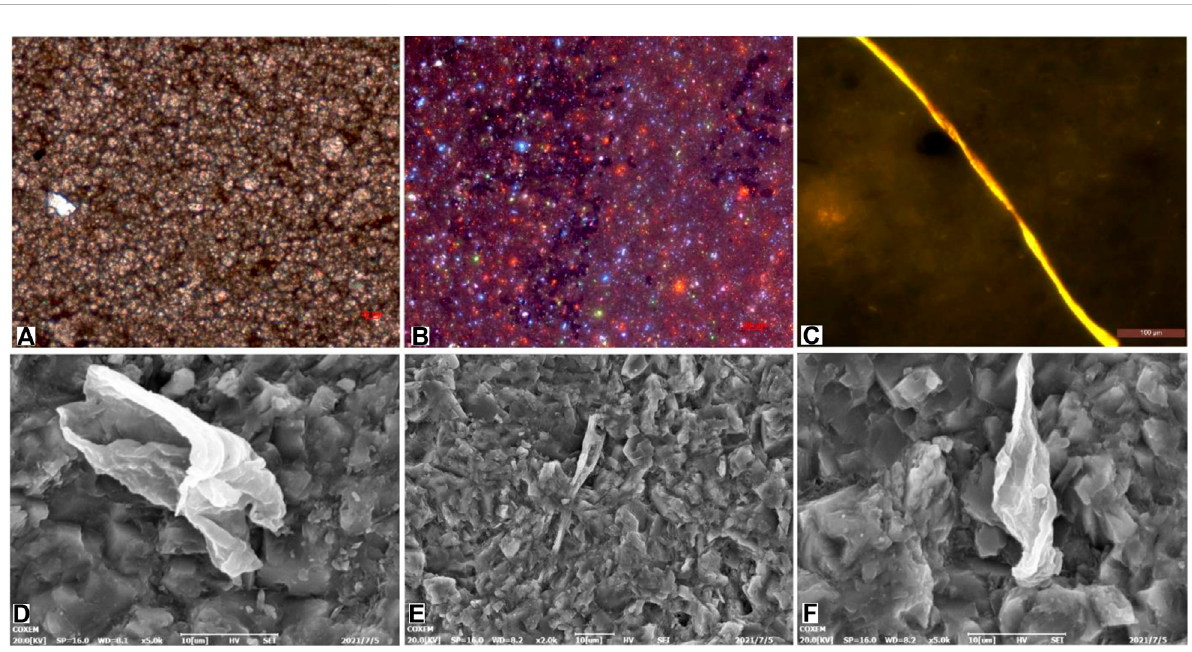
FIGURE 5 Optical, cathodoluminescence, and scanning electron microscopy (SEM) images of the concretions. (The test areas are shown in Figure 4B. Images A and B are derived from box 1 in Figure 4B. Image C is derived from box 2 in Figure 4B. Images D, E, and F are derived from box 3 in Figure 4B.). (A) Transmission light microscopy shows that the microcrystalline dolomite in the concretions occurs homogeneously. (B) Cathodoluminescence microscopy revealed that dolomite shows orange-red fl uorescence. (C) Fluorescence microscopy revealed organic matter. (D – F) SEM showed